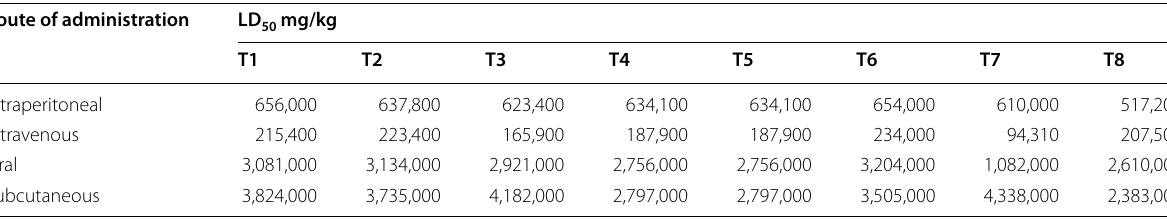
Table 3 Binding affinity energies and root‑mean‑square deviation (RMSD) values obtained after docking run of ligands (T1 to T8) with target protein LOXL2 Ligand–target